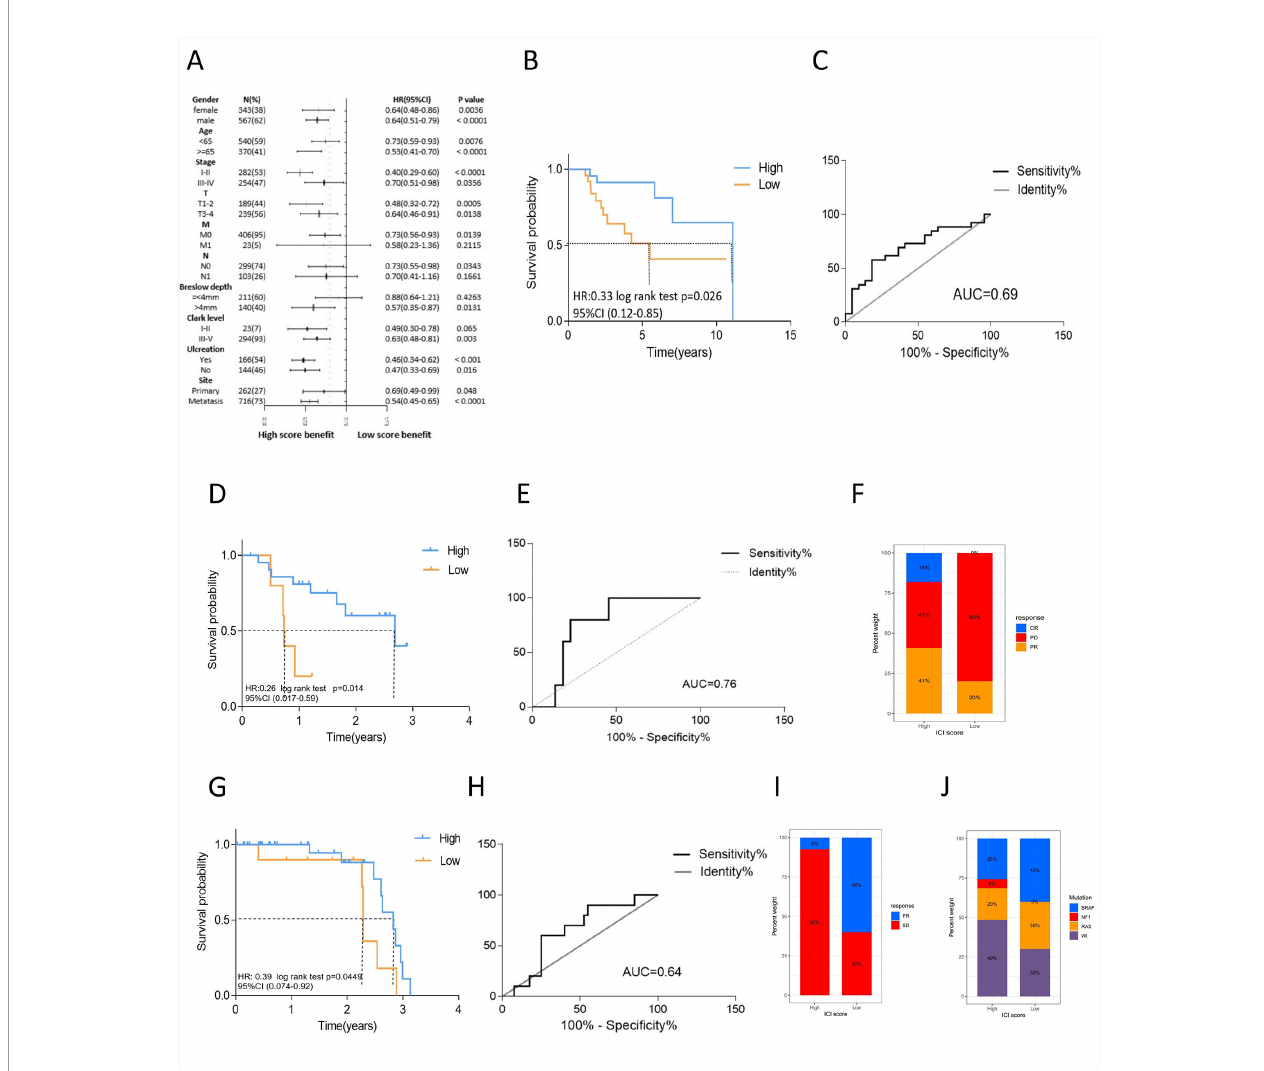
FIGURE 5 | The role of ICI scores in the evaluation of melanoma clinical characteristics and immune therapy bene fi t. (A) The forest plot of strati fi ed survival analysis for clinical indicator based on ICI score. The length of the horizontal line represents the 95% CI for each group, the sample number, HR and 95%CI as well as P value of each group were listed. (B) Kaplan-Meier curves of overall survival for high and low ICI score cluster in GSE19423 cohort. Log rank test P =0.026. (C) The predictive value of the ICI score measured by ROC curves in GSE19423. (D) Kaplan-Meier curves of overall survival for high and low ICI score cluster in GSE78220. Log rank test P =0.014. (E) The predictive value of the ICI score measured by ROC curves in GSE78220. (F) Rate of clinical response to anti-PD1 treatment in high and low ICI score groups in GSE78220. (G) Kaplan-Meier curves of overall survival for high and low ICI score cluster in CA209038 cohort. Log rank test P =0.0449. (H) The predictive value of the ICI score measured by ROC curves in CA209038. (I) Rate of clinical response to anti-PD1 treatment in high and low ICI score groups in CA209038 cohort. (J) Mutation frequency between high and low ICI score group in CA209038